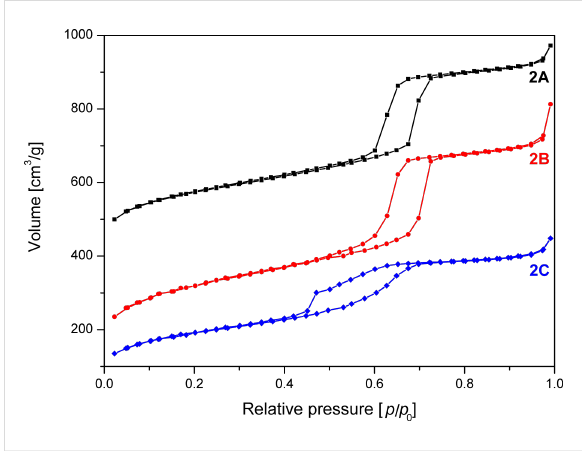
Figure 4: N 2 adsorption/desorption isotherms of SBA-15 unwashed ( 2A ), after washing with 5 mL ( 2B ) and 30 mL ( 2C ) quantities of solvent. The isotherms are offset by 350 ( 2A ) and 50 ( 2B ) cm 3 /g.